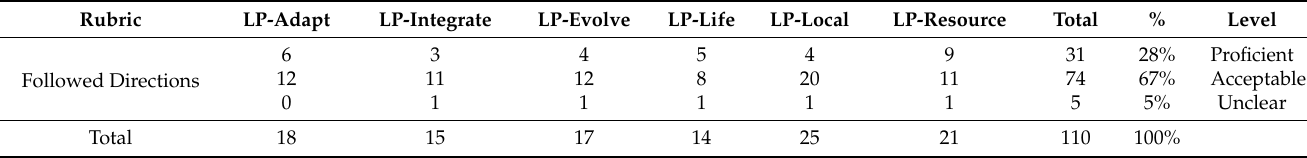
Table 3. Life’s Principles rubric data collection